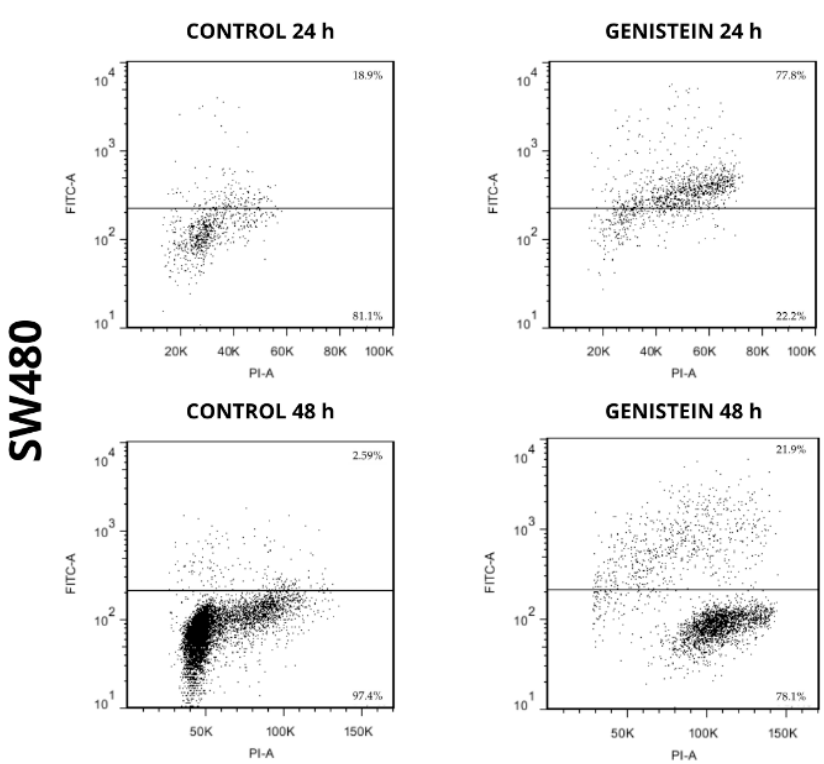
Figure 7. Genistein induces cell death in SW480 cell line. Dot plot of PI/FITC in SW480 cell line after treatment with genistein in two periods of time (24 h and 48 h).